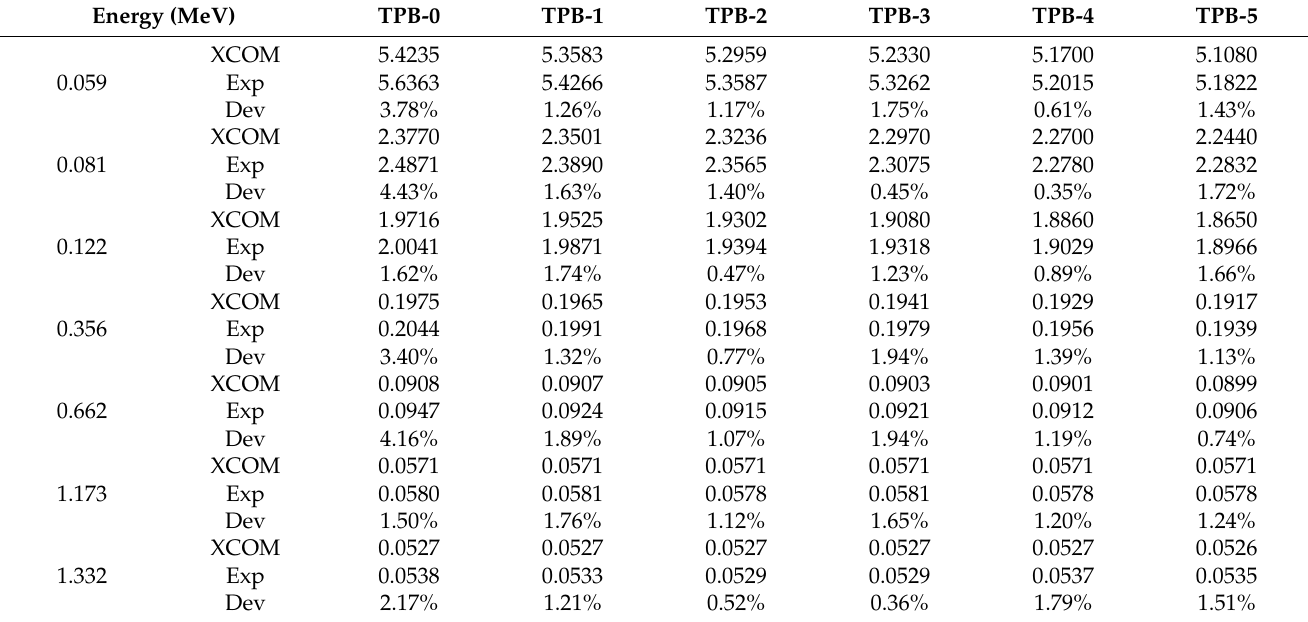
Table 2. Compare the mass attenuation coefficient values µ m (cm 2 /g) obtained by the TPB series glass experiment and WinXCOM